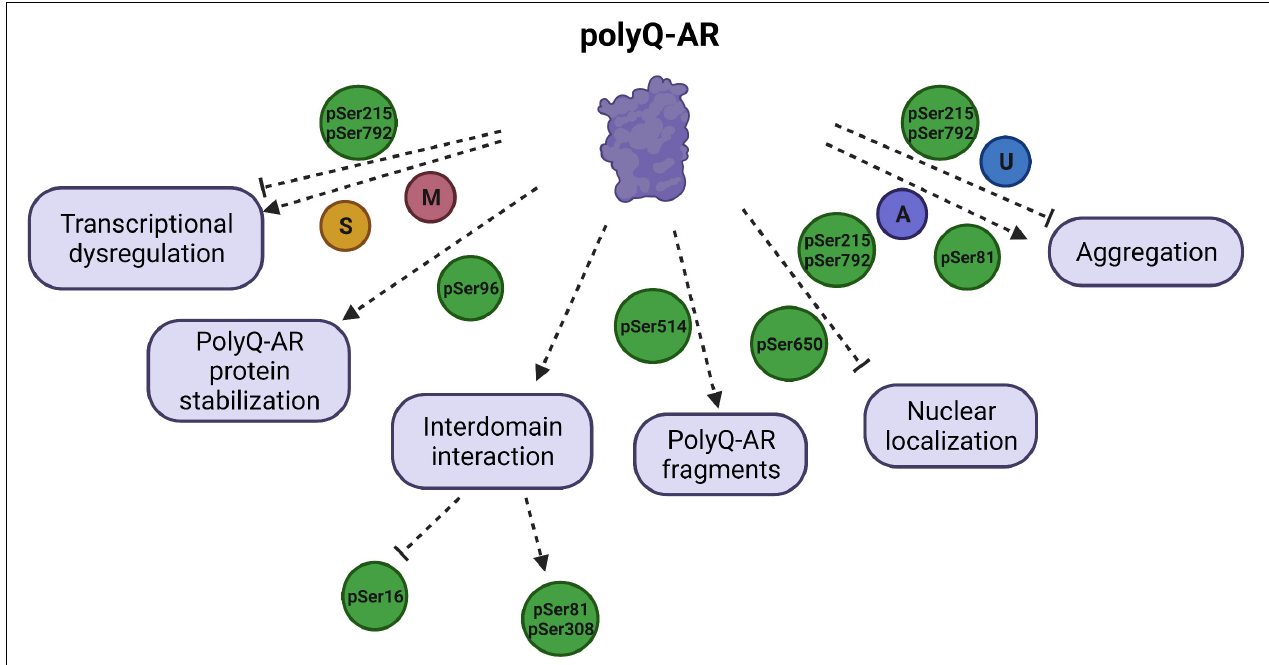
FIGURE 2 | Schematic illustration of polyglutamine (polyQ) -AR functions targeted by PTMs and their effects on the SBMA disease pathology. PTMs regulate the diverse functions of polyQ-AR, and thereby play a critical role in SBMA pathogenesis. Transcriptional dysregulation by polyQ-AR is improved by phosphorylation at S215 (pSer215) and S792 (pSer792) but enhanced by methylation (M) at arginine residues of polyQ-AR by PMRT6. SUMOylation (S) was reported to decrease transactivation of polyQ-AR. Stabilization of polyQ-AR protein is increased by phosphorylation at S96 (pSer96). Phosphorylation of AR at S16 is found to be increased by inhibition of interdomain interaction. AR phosphorylation at S81 and S308 is dependent upon AR N/C interaction. Phosphorylation at S514 (pSer514) leads to formation of toxic polyQ-AR fragments. Nuclear localization of polyQ-AR is reduced by pSer215 and pSer792. Phosphorylation at S650 (pSer650) enhances the nuclear export of polyQ-AR. AR aggregation can be reduced by pSer215, pSer792, ubiquitination (U), but promoted by pSer81 and acetylation (A).